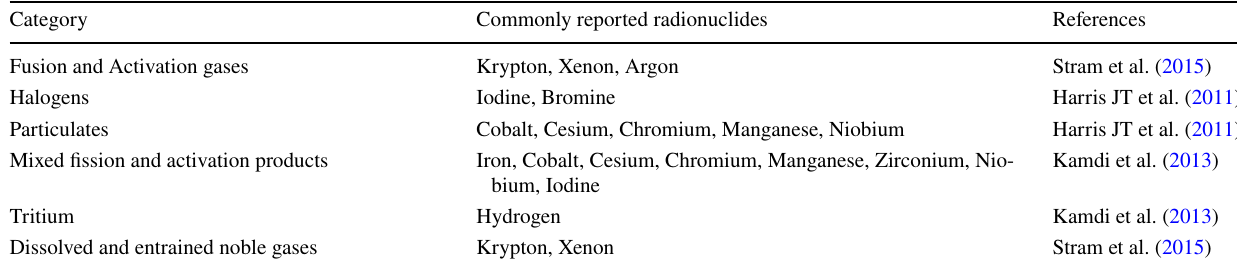
Table 2 Common radioactive nucleotides Category